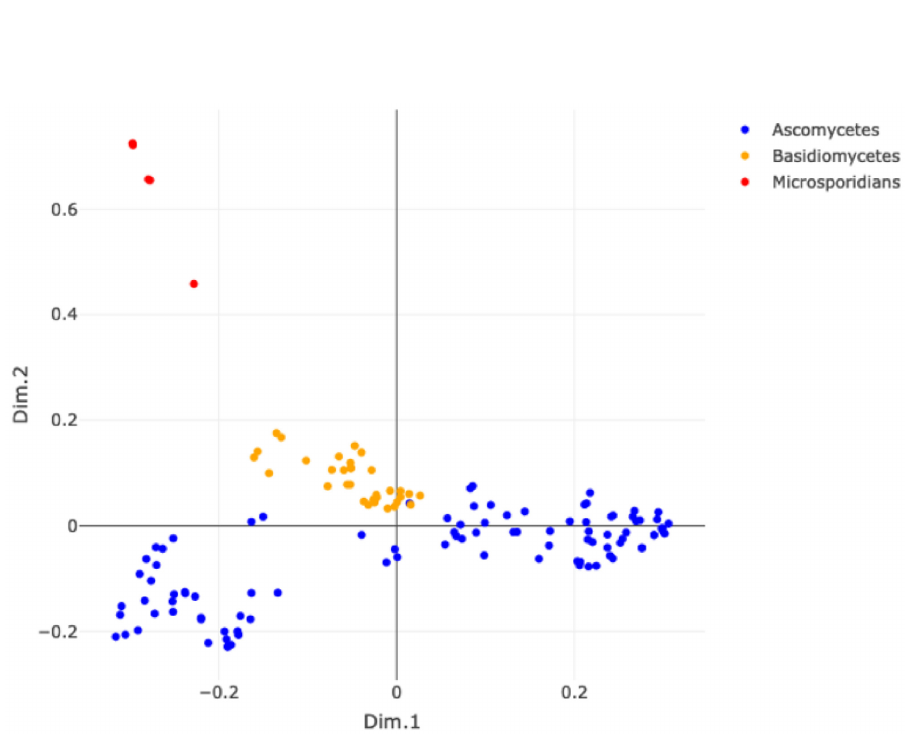
Fig 5. MDS plot of the SP similarity matrix of all KEGG Protophotophytes (left) and composition of clusters w.r. t. a total of three clusters for the SP graph kernel.